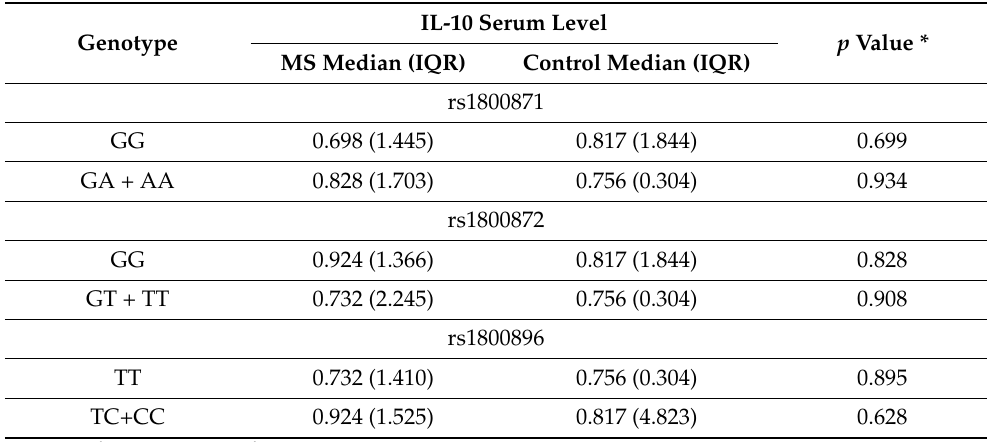
Figure 1. Interleukin-10 concentrations between the groups. Considering the associations between the SNP genotypes and the IL-10 levels, we analyzed the IL-10 levels in the different genotype groups, but no statistically significant differences were found (Table 5). Table 5. Genotype distribution and IL-10